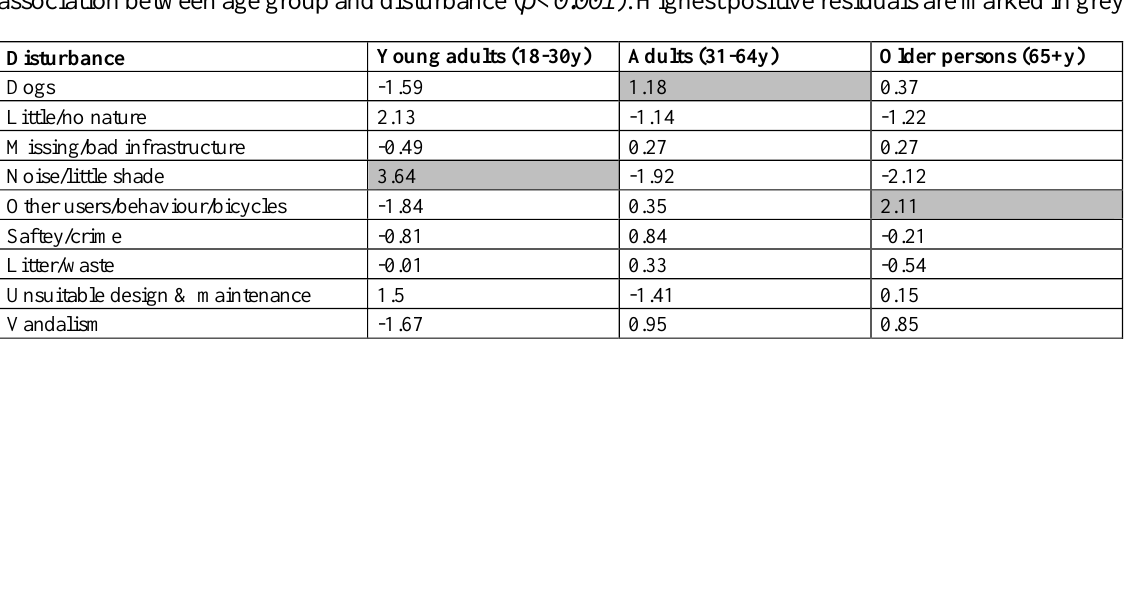
Table A1.3: Pearson’s residuals of chi-square test for perceived disturbances in urban parks. Positive values mean a positive association between age group and disturbance, negative values mean negative association between age group and disturbance ( p<0.001 ). Highest positive residuals are marked in